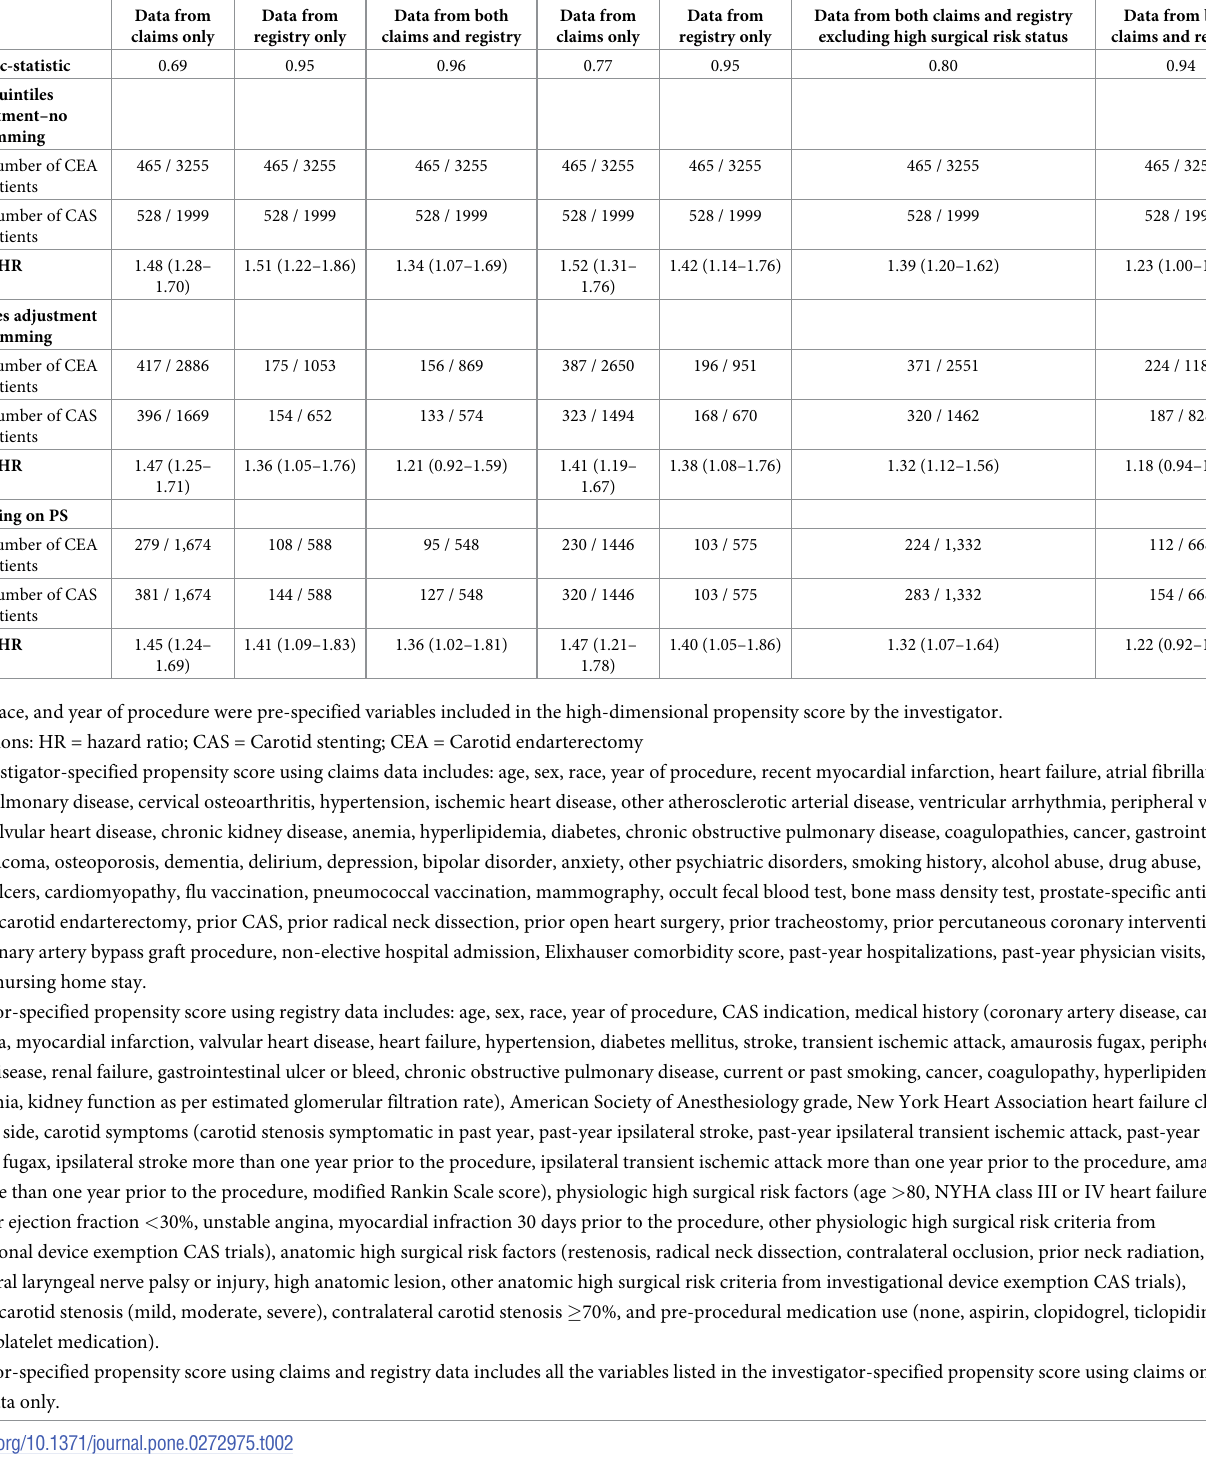
Table 2. Number of events, total cell sizes and hazard ratios for CAS relative to CEA based on different propensity score adjustment techniques across the different propensity score models. Propensity score models from investigator-specified